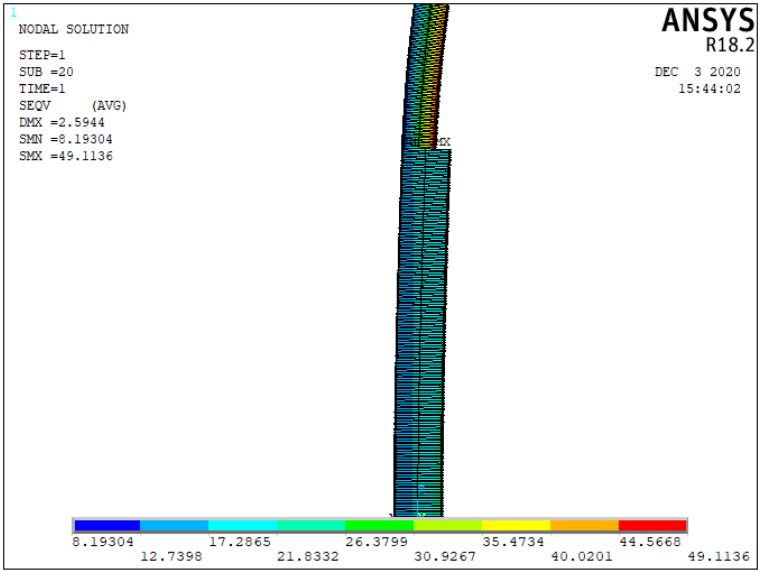
Figure 10. Mises stress diagram of the steel bent frame column.